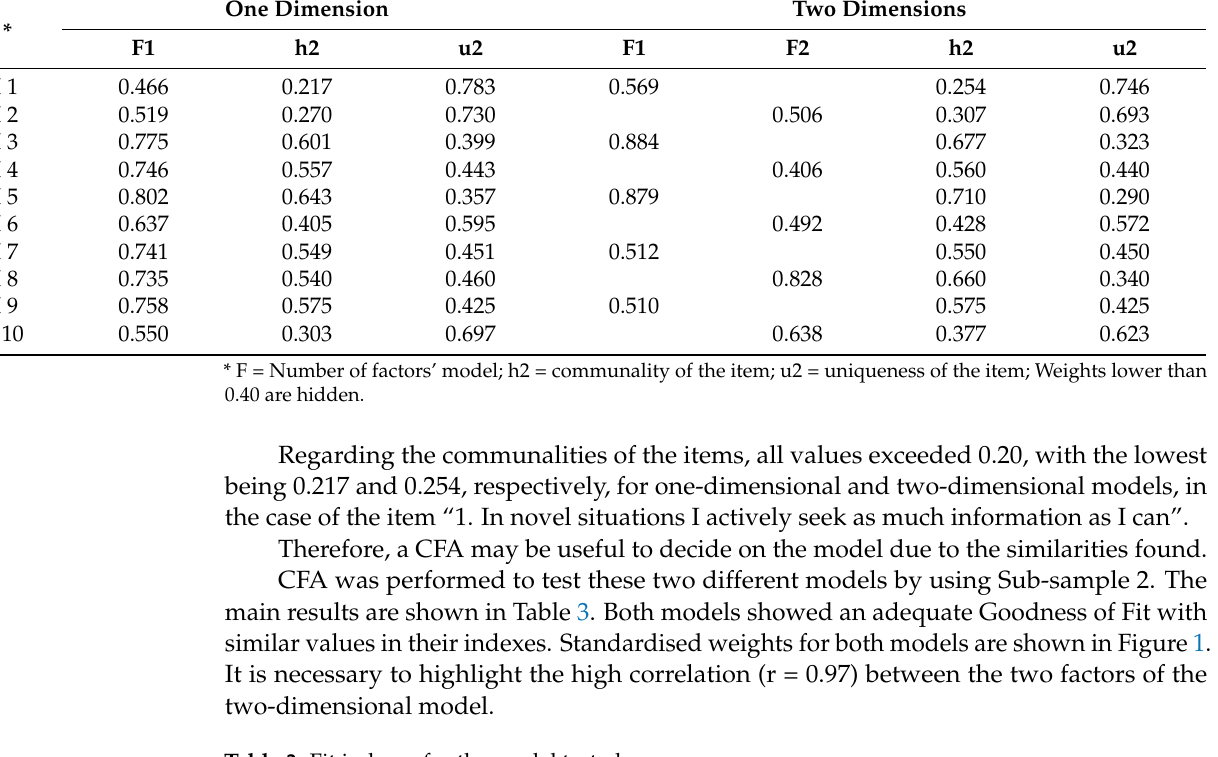
Table 3. Fit indexes for the model